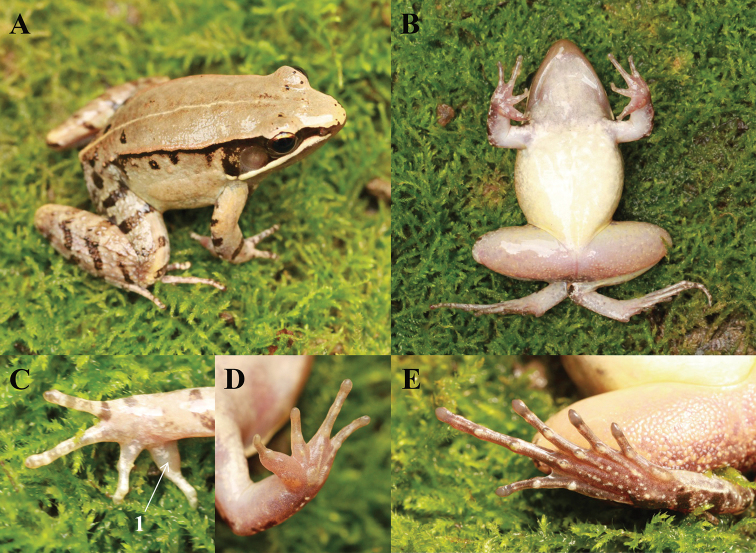
Photos of the holotype CIBTZ20190608004 of Nidirana
yeae sp. nov. in life. A Dorsal view B ventral view C dorsal view of hand D ventral view of hand E ventral view of foot. Key: 1 indicates nuptial pad on the inner side of finger I.